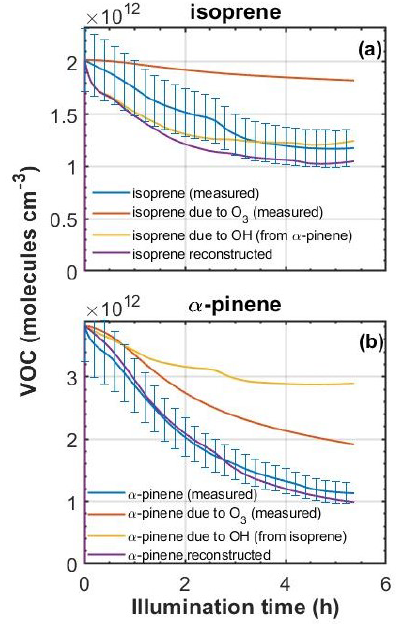
Figure 7. Measured ( ± 15% error) and reconstructed decays of (a) isoprene and (b) α -pinene in an α -pinene–isoprene binary ex- periment. First, in each case the decay of the VOC due to ozone was predicted based on the O 3 concentration, the reaction rate of each VOC toward O 3 , and the initial VOC concentration. Second, the OH concentration from each VOC was estimated from the dif- ference in the VOC decay attributed to O 3 and the measured VOC decay. Finally, the OH concentration from each precursor was used to reconstruct the decay of the other (i.e. OH from isoprene was used to reconstruct the decay of α -pinene and vice